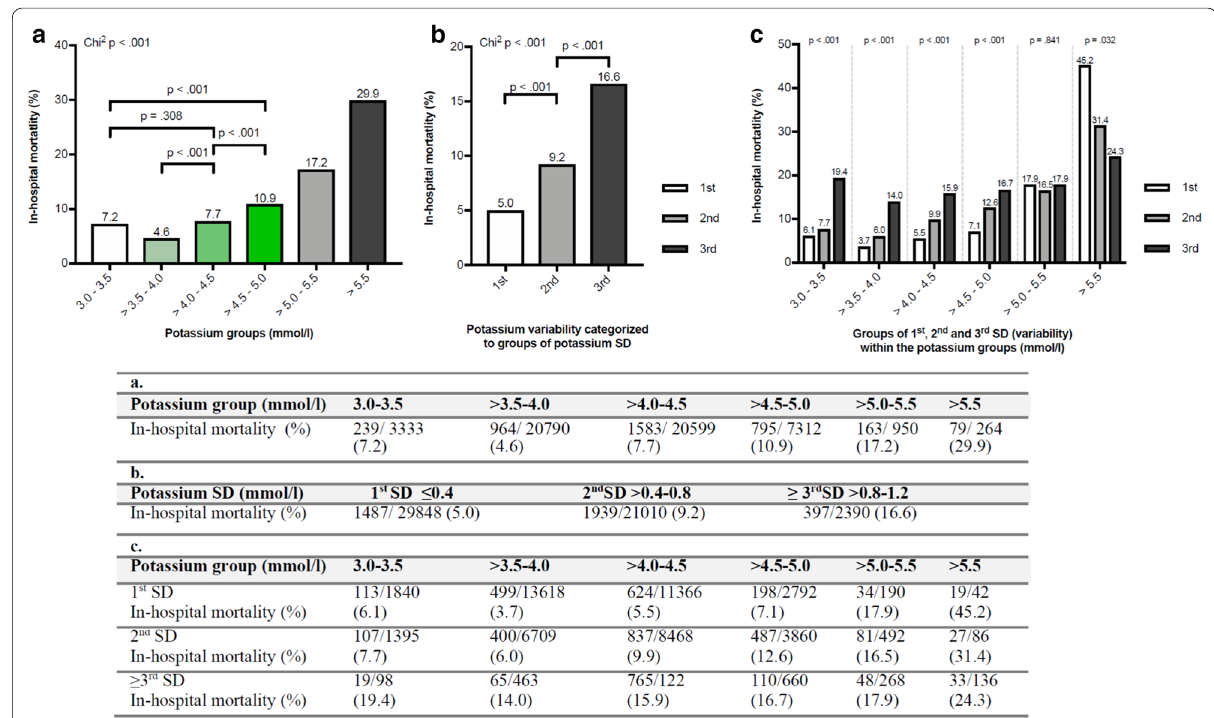
Fig. 1 Association between mean potassium and variability groups and in‑hospital mortality, n number of patients and the number of deaths in each group. χ 2 test for all groups, Fisher Exact test for comparison between subgroups. a In‑hospital mortality rate is lowest in potassium range > 3.5–4.0 mmol/l. b Groups of potassium variability shown in 1st, 2nd and potassium. In‑hospital mortality is lowest in the 1st SD and increases in each group. χ 2 test for all groups and comparison between subgroups. c Lowest in‑hospital mortality rate (3.7%) was observed in patients with low variability (1st SD) and mean potassium concentrations > 3.5–4.0 mmol/l. Groups within the potassium normal range (3.5–5.0 mmol/l) are coloured green. p values determined by χ 2